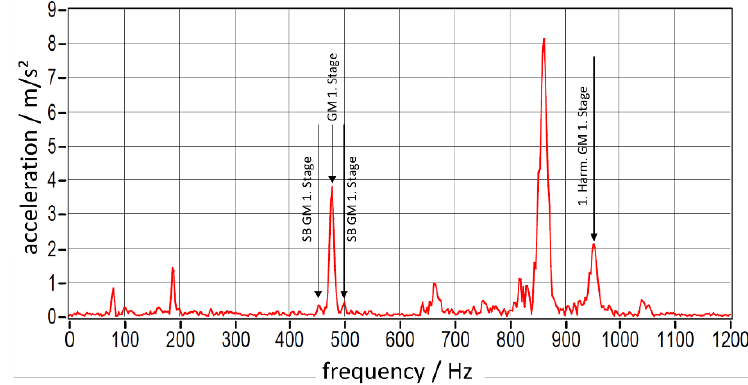
Figure 11. Frequency spectrum of an acceleration signal detected with wireless sensors on the gearbox of the same tram approximately 1.5 years later at an approximate speed of 50 km/h (detail).